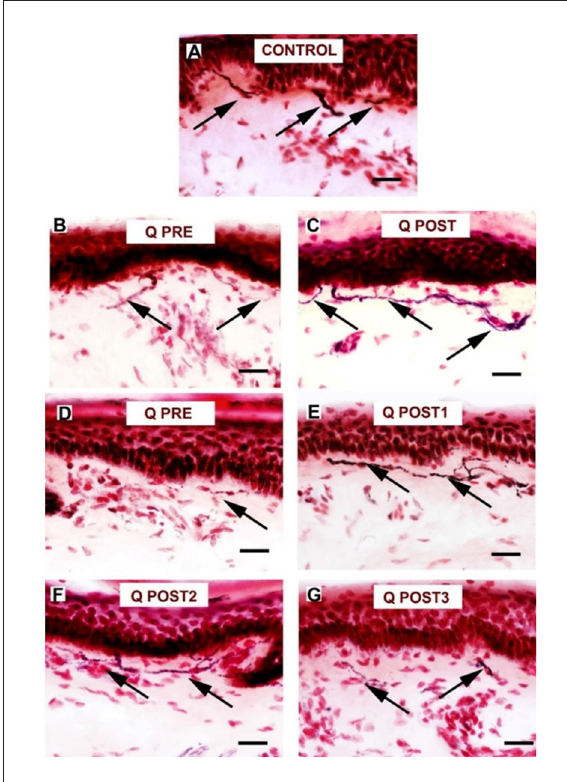
FIGURE9 Staining for GAP 43 in control skin, NPDPN Q + SOC and PDPN Q + SOC before and after application of Capsaicin 8% patch Qutenza (Q) treatment. (A) Control skin biopsy section, from a healthy human volunteer (sub–epidermal nerve fibers marked with arrows).